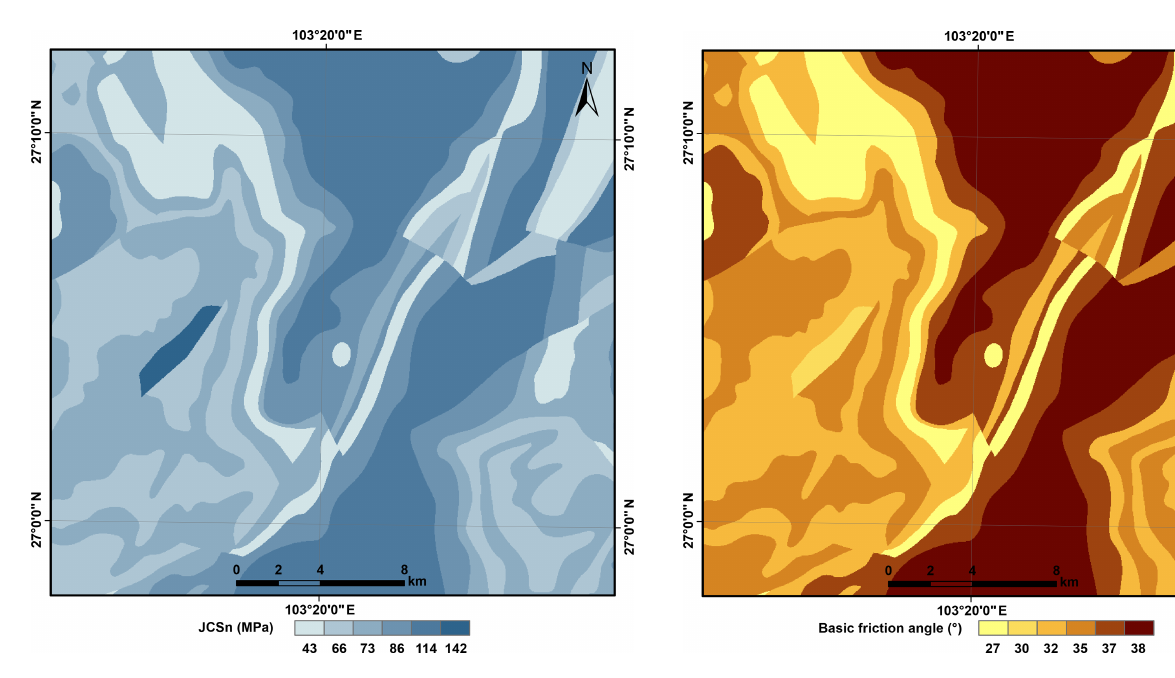
Figure 9. JCS n component of shear strength assigned to rock types in the study area.